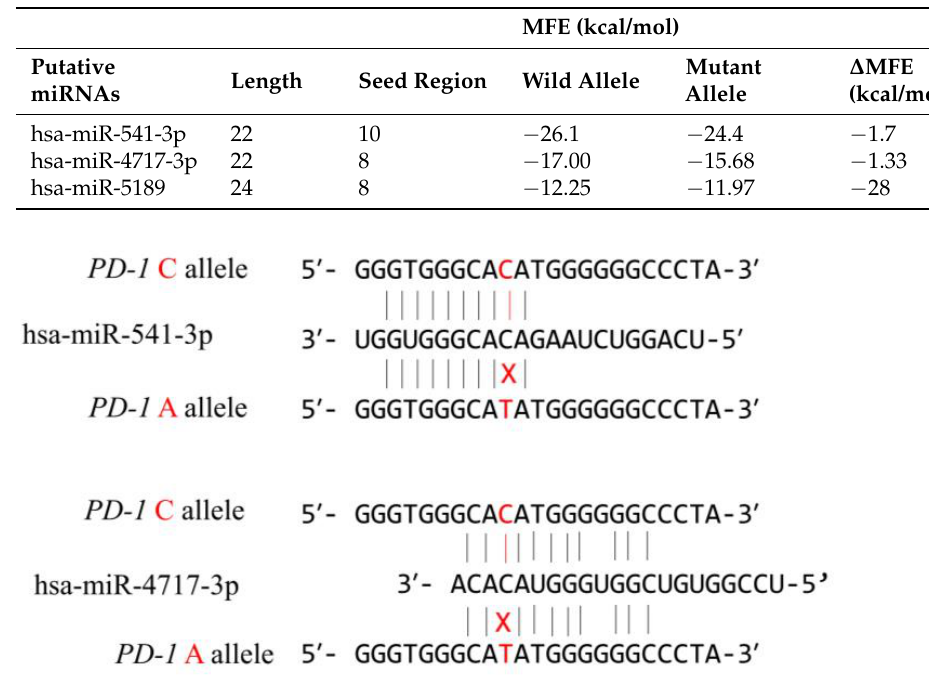
Figure 3. Putative miRNA binding sites in wild type and mutant allele, showing the disruption of the interaction between miRNA and its predicted target site in mutant type.